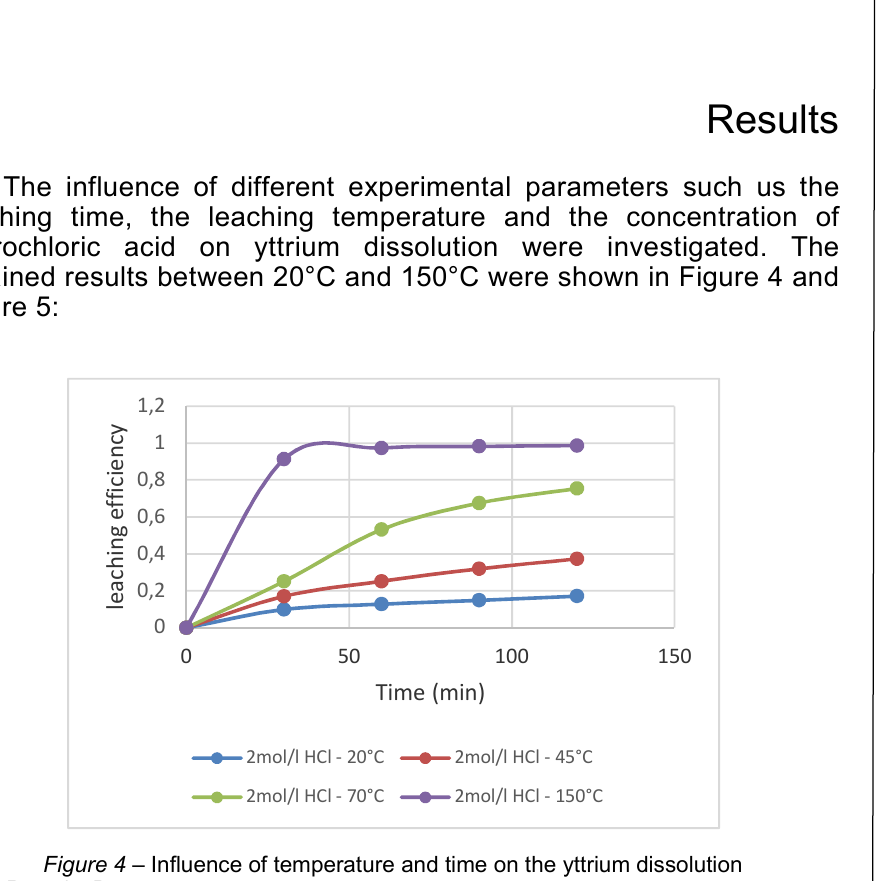
Figure 4 – Influence of temperature and time on the yttrium dissolution Рис . 4 – Влияние температуры и времени на процесс растворение иттрия Sliika 4 –Uticaj temperature i vremena na rastvaranje